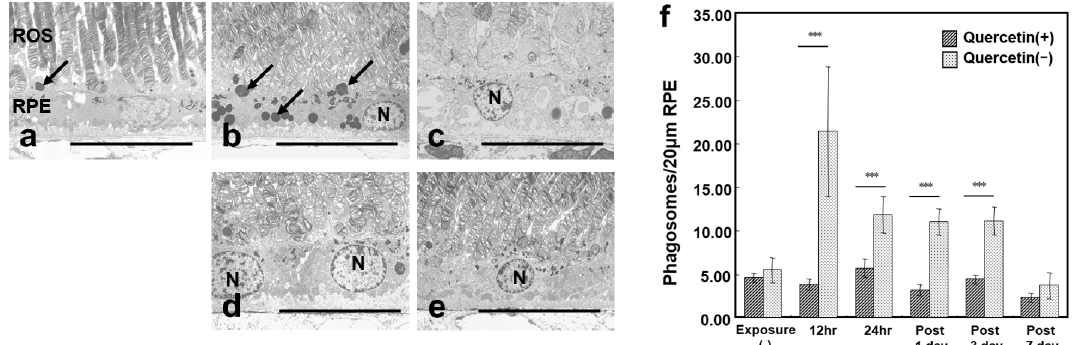
Figure 5. The rod outer segment (ROS) microstructure and phagosomes in the RPE. Superior retinal samples obtained from about 500 µ m from the optic nerve are observed. ( a ) Unexposed RPE cells contain some phagosomes (arrow). ( b ) Quercetin ( − ) retinas have many phagosomes (arrows) after 12 h of exposure; ( c ) the arrangement of the ROS is disrupted 7 days after light exposure. ( d ) In quercetin ( + ) retina, the RPE cells are almost the same as the normal retinas during and ( e ) after exposure. ( f ) The number of phagosomes in 20- µ m-long RPE has increased during and after exposure only in quercetin ( − ) retina. Bar = 5 µ m. The data are expressed as the mean ± SD ( n = 12). *** p < 0.001 by the Mann-Whitney U test. hr, hours; N: nucleus.